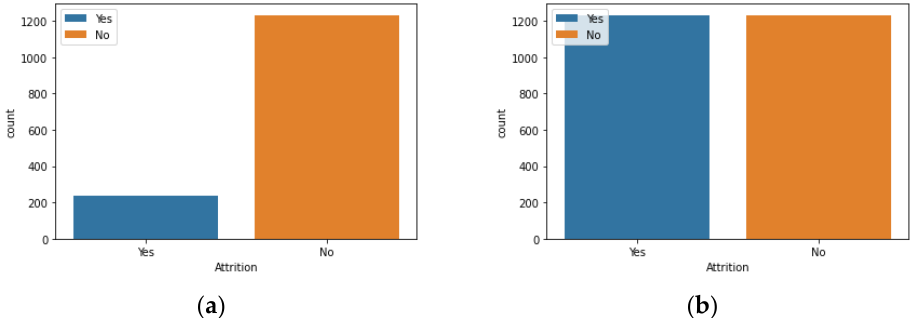
Figure 7. The dataset resampling using SMOTE technique was applied: ( a ) describe the unbalanced target category; ( b ) describe the target category after balancing the dataset.